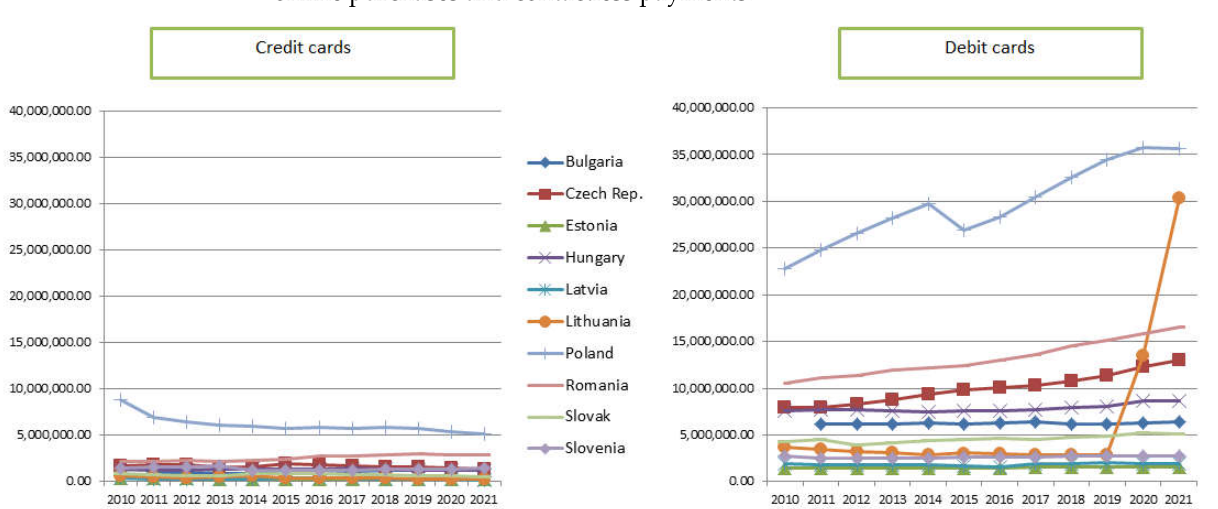
Figure 4. Internet use: internet banking (IB).